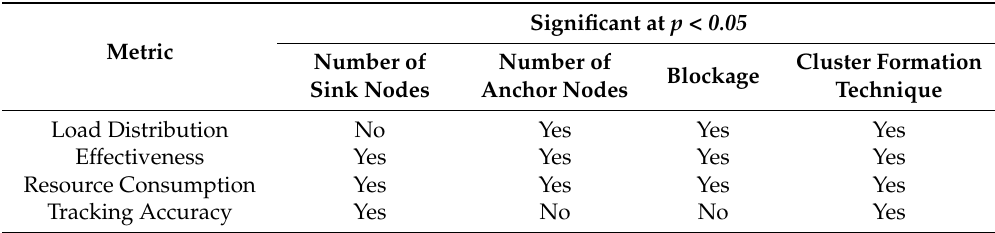
Table 4. Statistical results for the WSN simulations.